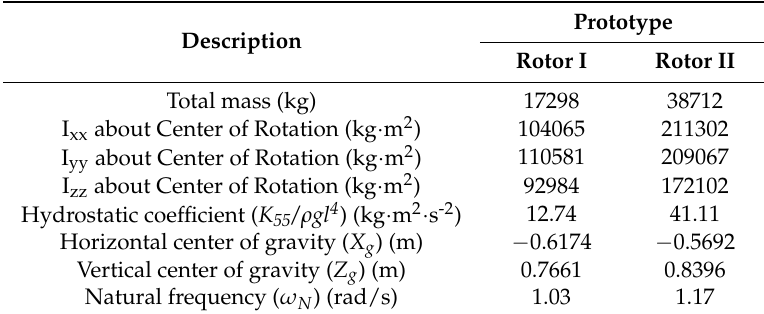
Table 1. Details of the prototype WEC